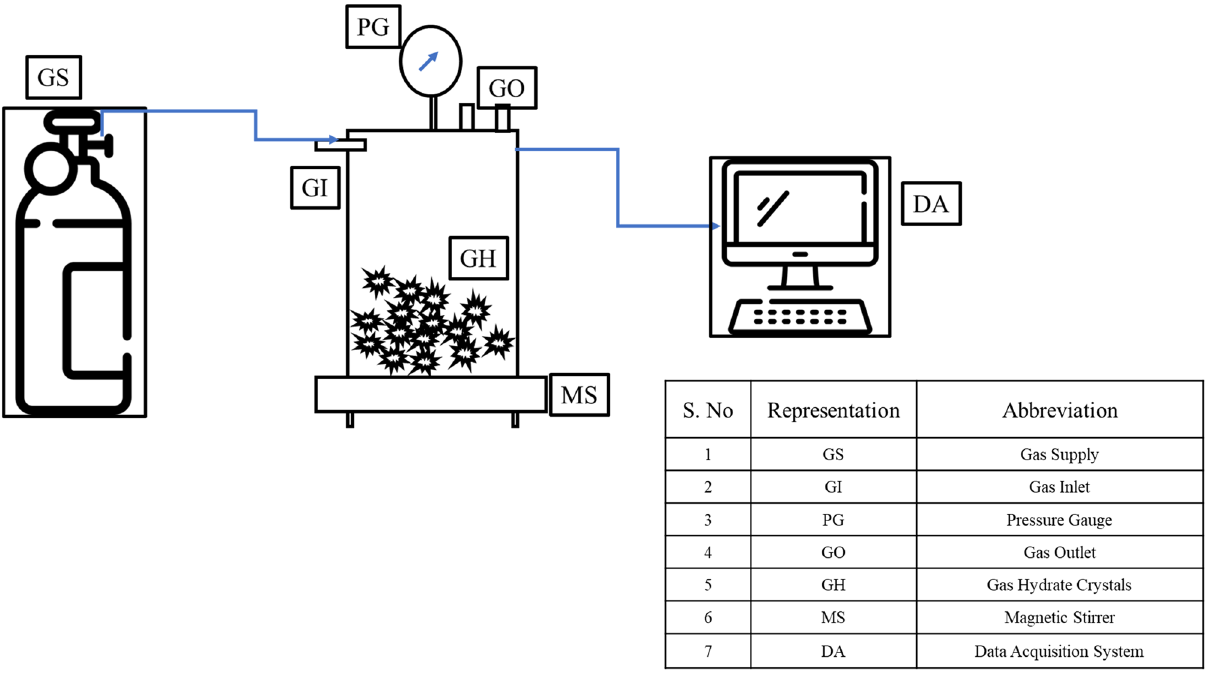
Figure 3. Experimental setup